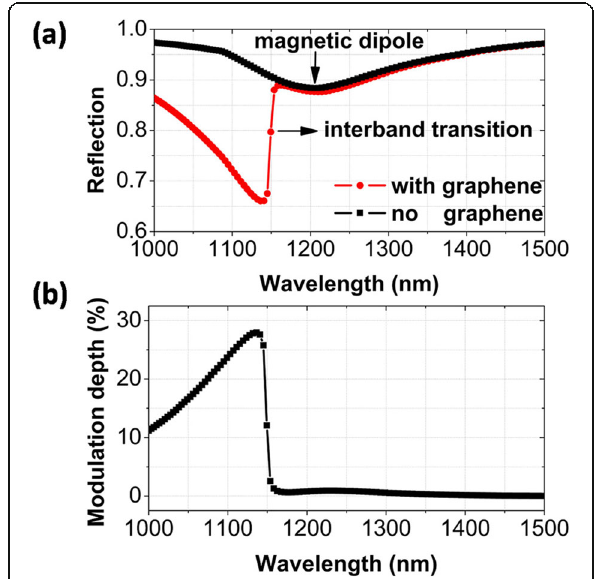
Fig. 2 a Numerically calculated refection spectra of metamaterials with and without an inserted graphene monolayer, under normal incidence. b Modulation depth. Parameters: p x = 400 nm, w = 200